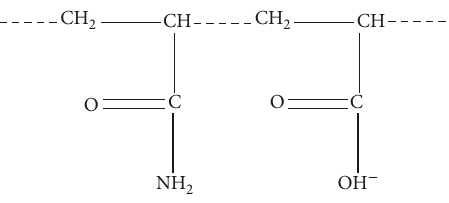
Figure 1: Molecular structure of